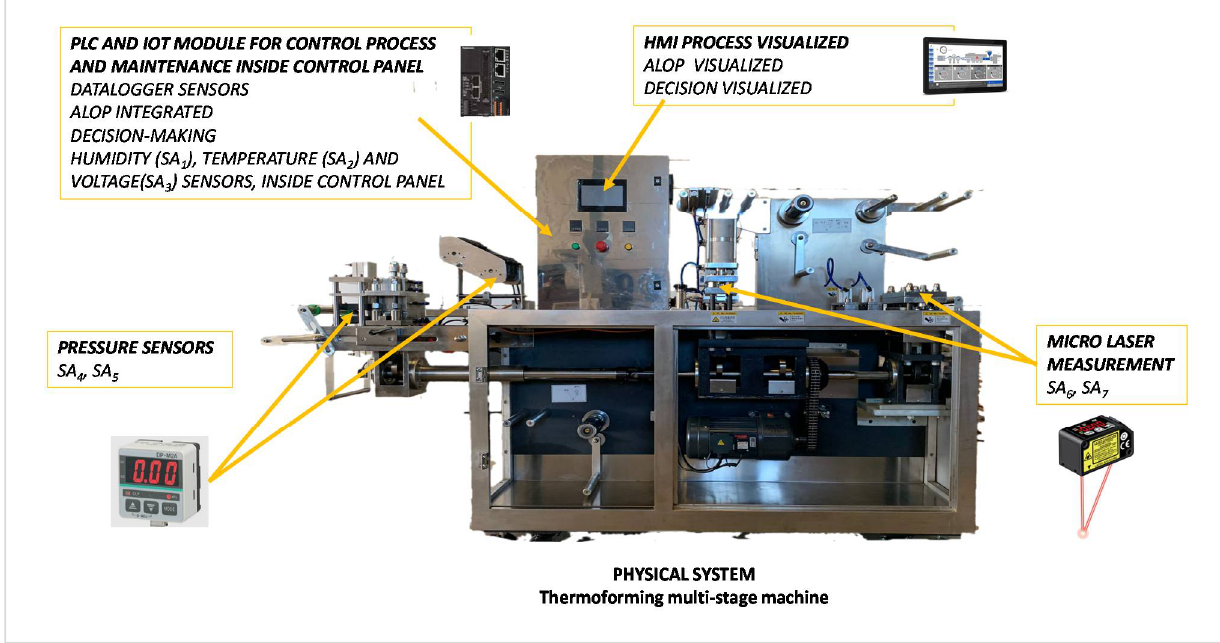
Figure 6. The setup of ALOP strategy.